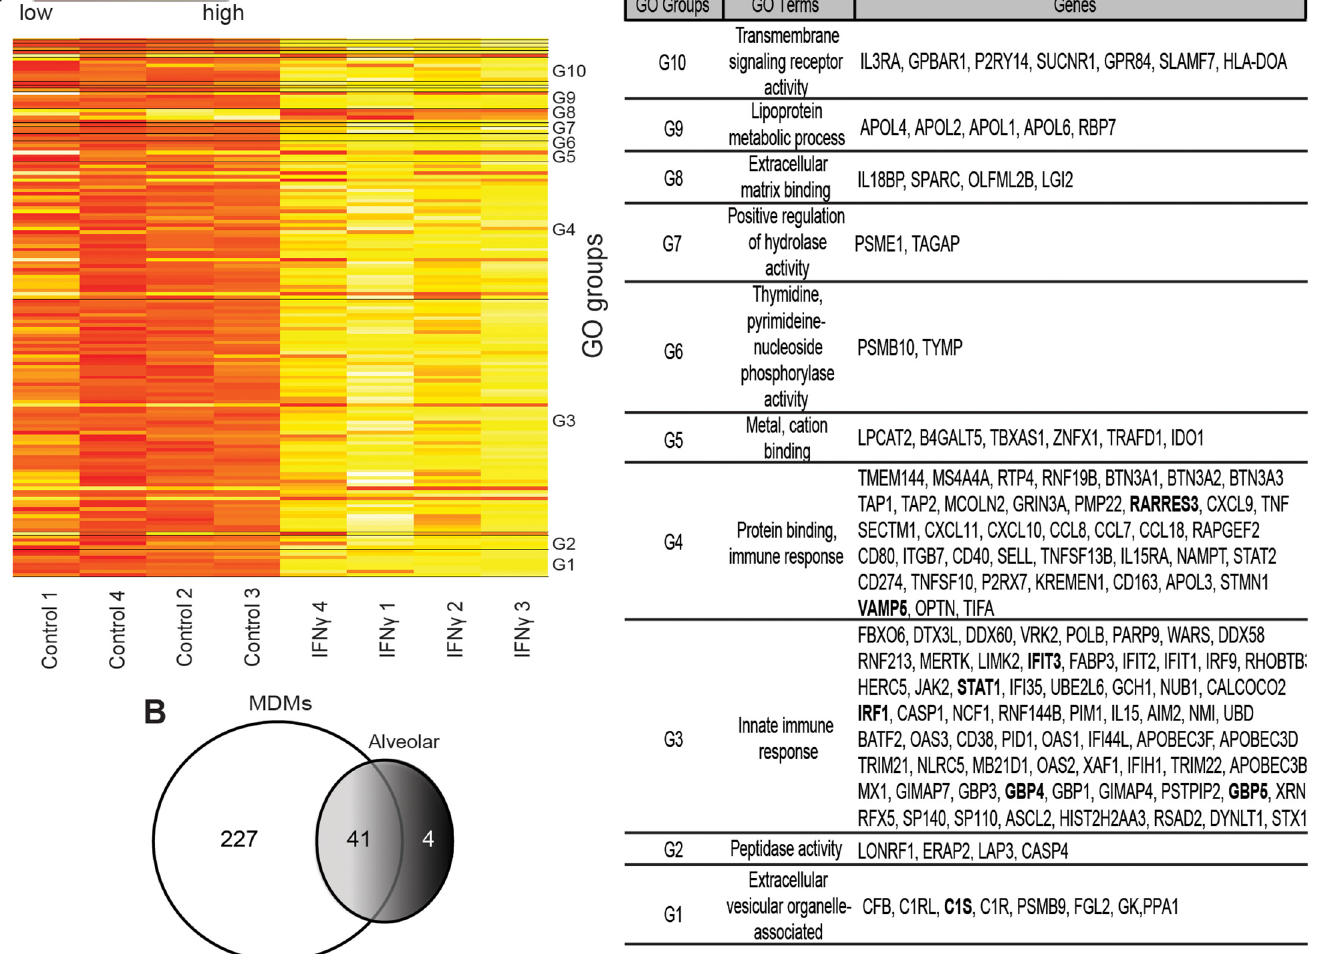
Fig 3. Human MDM gene expression is altered by 24 hours of IFN γ treatment. M-CSF cultured hMDMs were incubated with or without IFN γ for 24 hours and RNA was harvested for gene arrays. (A) Heat map summaries of hMDM gene expression significantly altered by IFN γ . Human MDMs were obtained from four different volunteers and treated with M-CSF or M-CSF plus IFN γ . Genes were clustered into annotated ontology groups and listed in the corresponding GO groups table with their respective GO terms. Significance was determined by paired t-test analysis with cutoff values of at least two-fold change and p < 0.01. NUSE analysis of the array demonstrated that the means were centered at a value of 1 and minimum and maximum values between 0.95 and 1.05. ISGs that were assessed further in this study are bolded in the GO table. (B) Venn diagram representing the statistically significant individual and shared genes altered by IFN γ in hMDMs and human alveolar